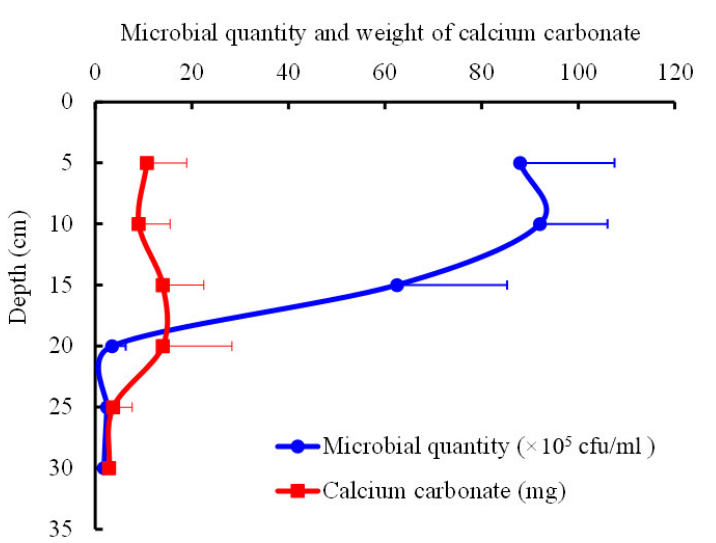
Figure 10. Distribution profiles of microorganisms and calcium carbonate in the sandy soil.